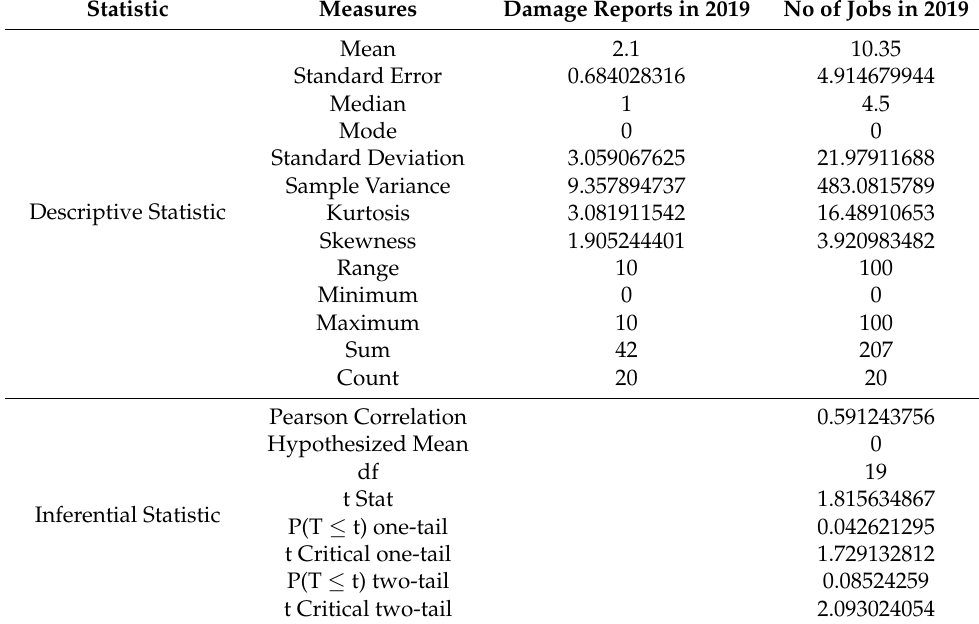
Table 5. Descriptive and inferential statistics result.